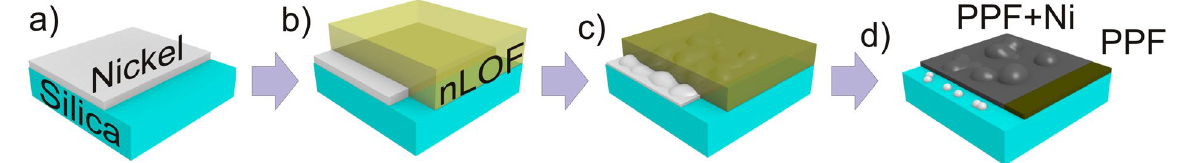
Figure 1. Sketch of the direct synthesis of the graphitic film on a dielectric substrate. ( a ) Physical deposition of the 10 nm thick Ni film; ( b ) Spin coating of the Ni with nLOF resist layer. ( c ) The pyrolysis of the resist and morphological changes in the Ni layer start at 600 °C; ( d ) At 800 °C the resist film is pyrolyzed and Ni film receds to nanoparticles.